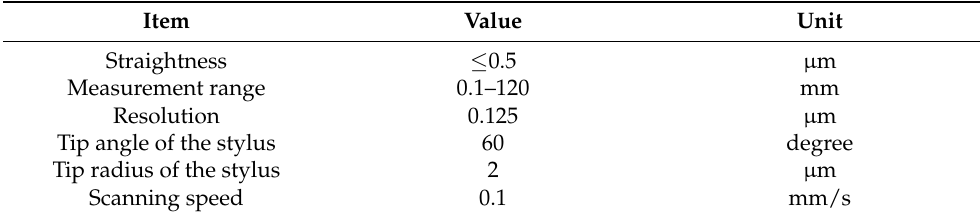
Figure 6. Schematic of the setup employed in experiments. Table 1. Measurement conditions. Table 1. Measurement conditions.